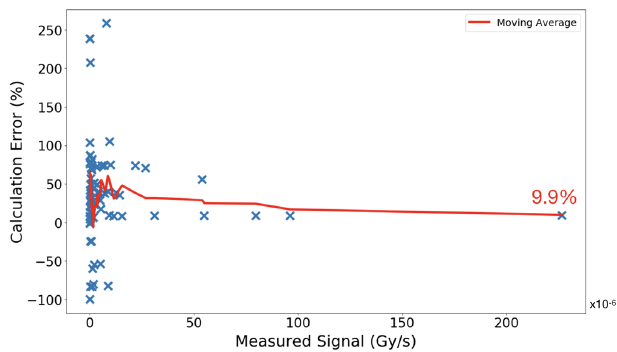
FIG. 10. Scatter plot of the measured signal points above 10 − 7 Gy = s, against the calculation error. The moving average was calculated showing the average error is mostly below 50% for low BLM signals and as small as 10% for high BLM signals.